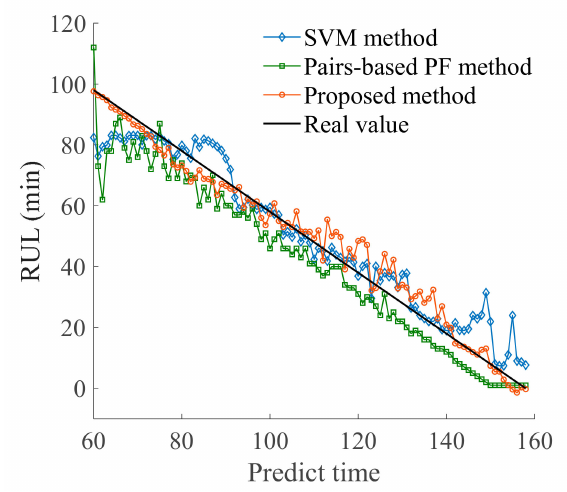
Figure 9. Comparison of prediction result.